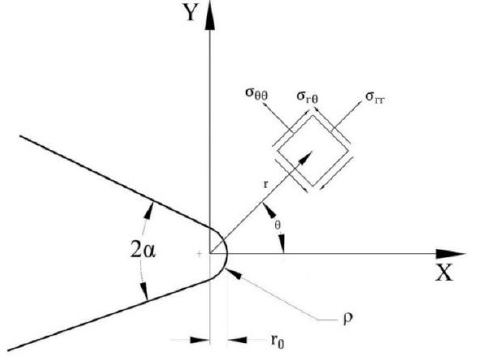
Figure 1. Round-tip V-notch with its Cartesian and polar coordinate systems.